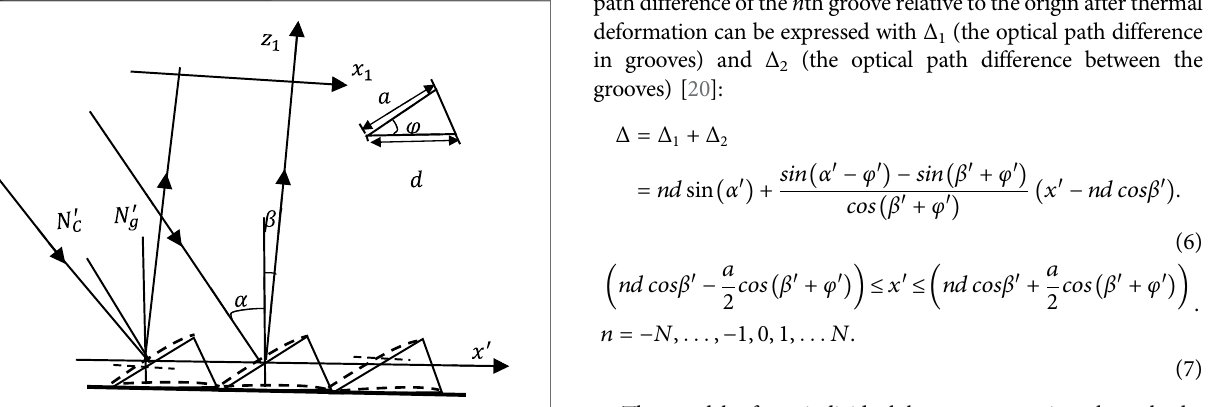
FIGURE 5 | Schematic diagram of optical path difference between grooves.